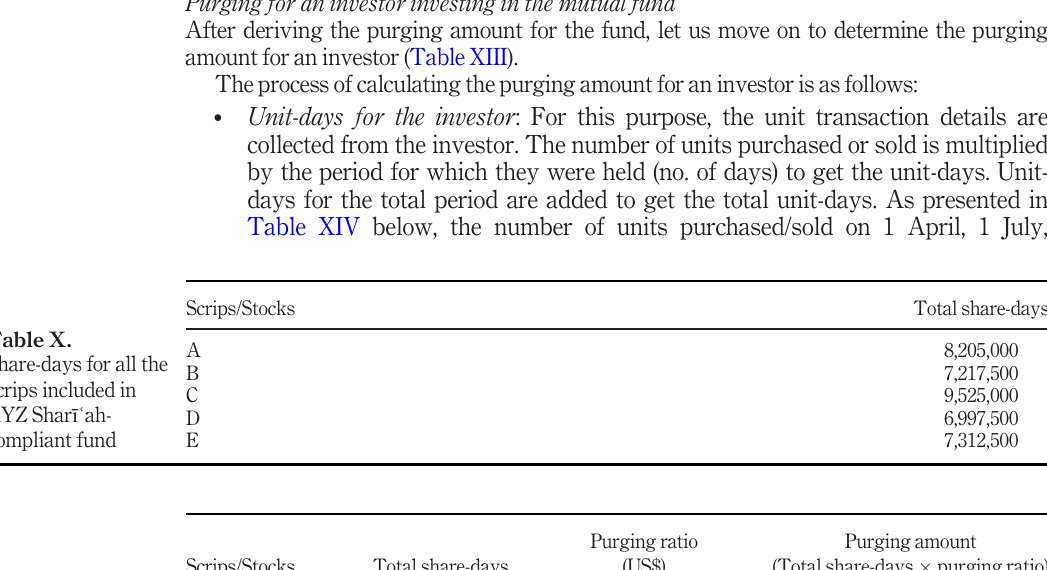
Table XI. Purging amount for all the scrips included in XYZ Shar ī ʿ ah-compliant fund